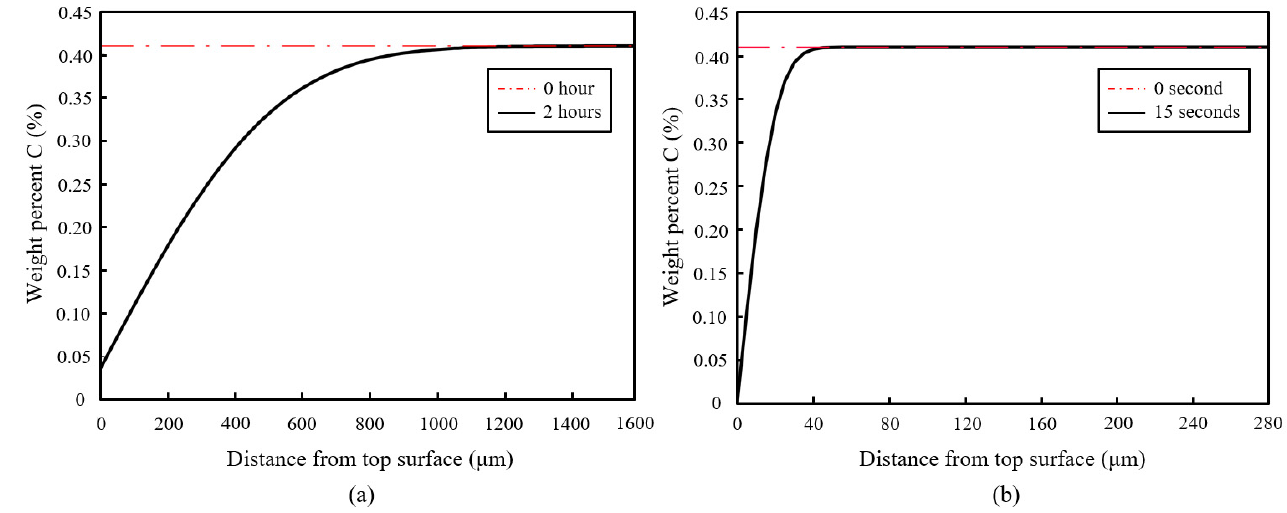
Figure 15. Simulation results showing the estimated decarburization depth of about: ( a ) 1200 μ m for furnace-heated sample and ( b ) 40 μ m for laser surface-hardening sample.